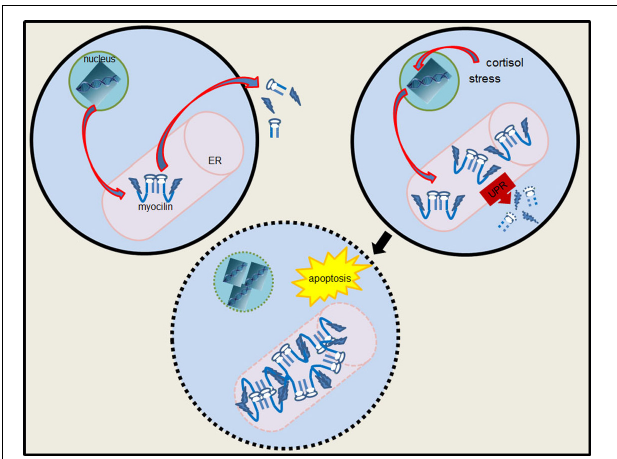
FIGURE 6 | Diagram of myocilin-induced endoplasmic reticulum stress and apoptosis. Overexpression of myocilin results in the formation of aggregates in the endoplasmic reticulum (ER) and activation of the unfolded protein response (UPR). If accumulation of myocilin aggregates exceeds the capacity of the unfolded protein response the apoptotic pathway is activated. Jagged shapes represent the N-terminal domain of myocilin with leucine zipper